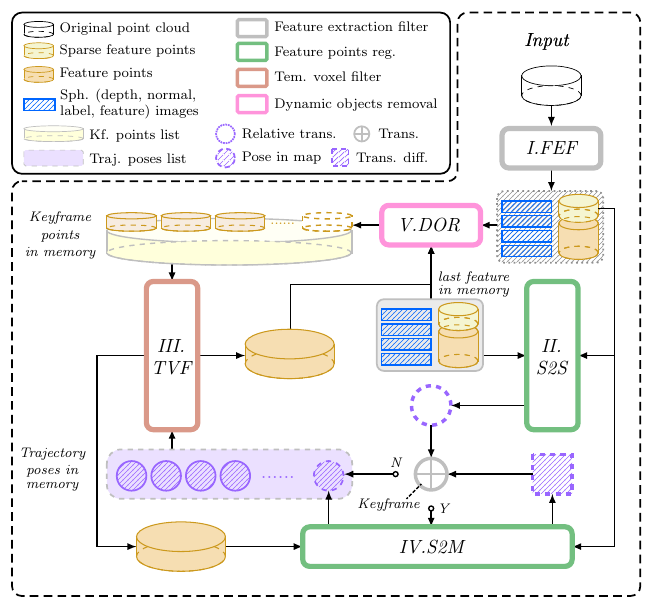
Figure 2. Overall workflow of